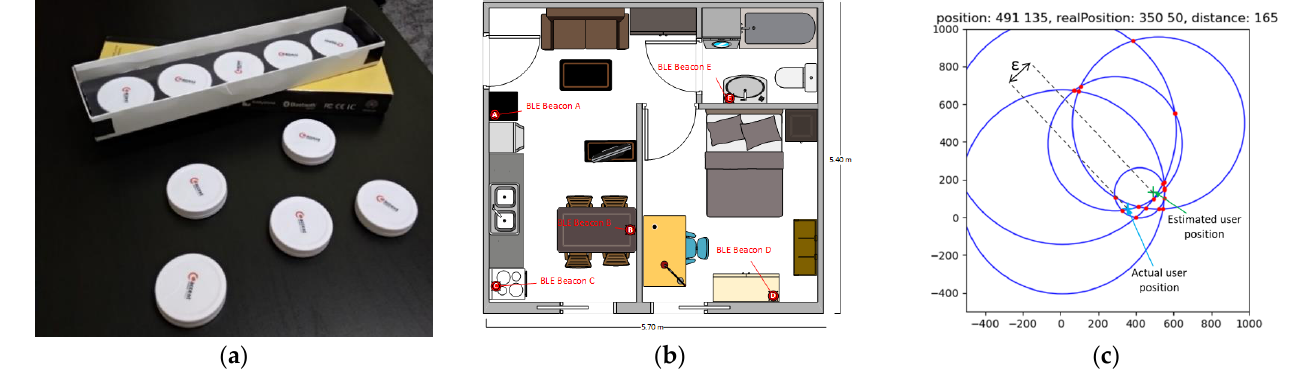
Figure 1. ( a ) Bluetooth beacons used in our experiments; ( b ) apartment map with beacon locations; ( c ) example result of the position inference method in [18].